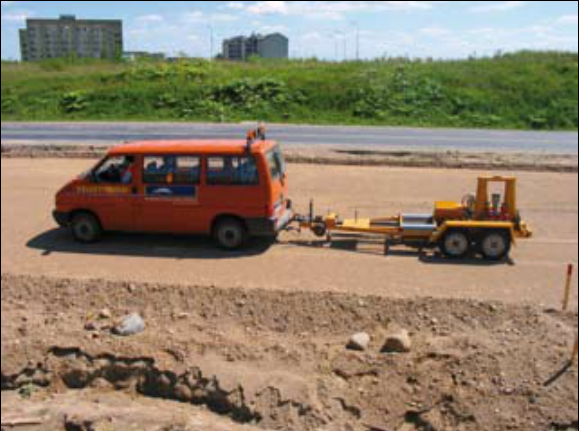
fig. 4. Falling Weight Deflectometer (FWD)